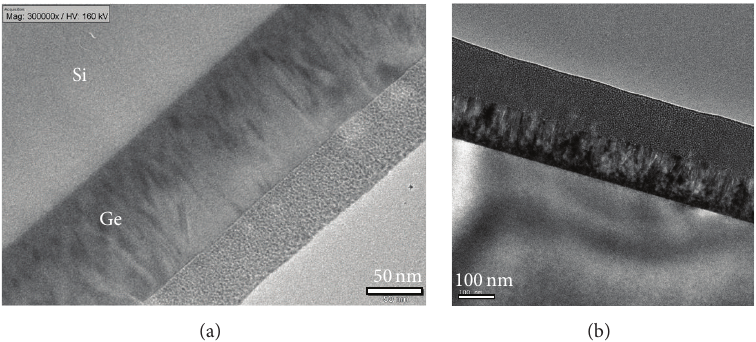
Figure 3: High resolution cross-sectional TEM image of the Ge films as deposited at H 2 flow rate of (a) 80sccm and (b) 60 sccm.